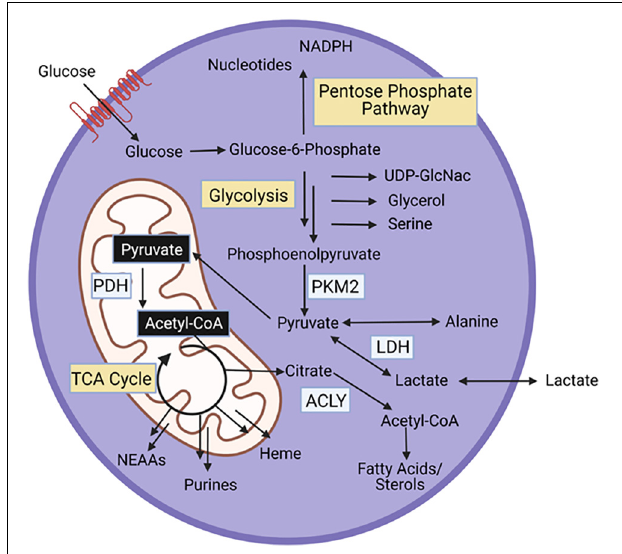
FIGURE 2 | Energy generating pathways and key protein in MPCs. PKM2, Pyruvate kinase M2; PDH, pyruvate dehydrogenase; ACLY, ATP Citrate